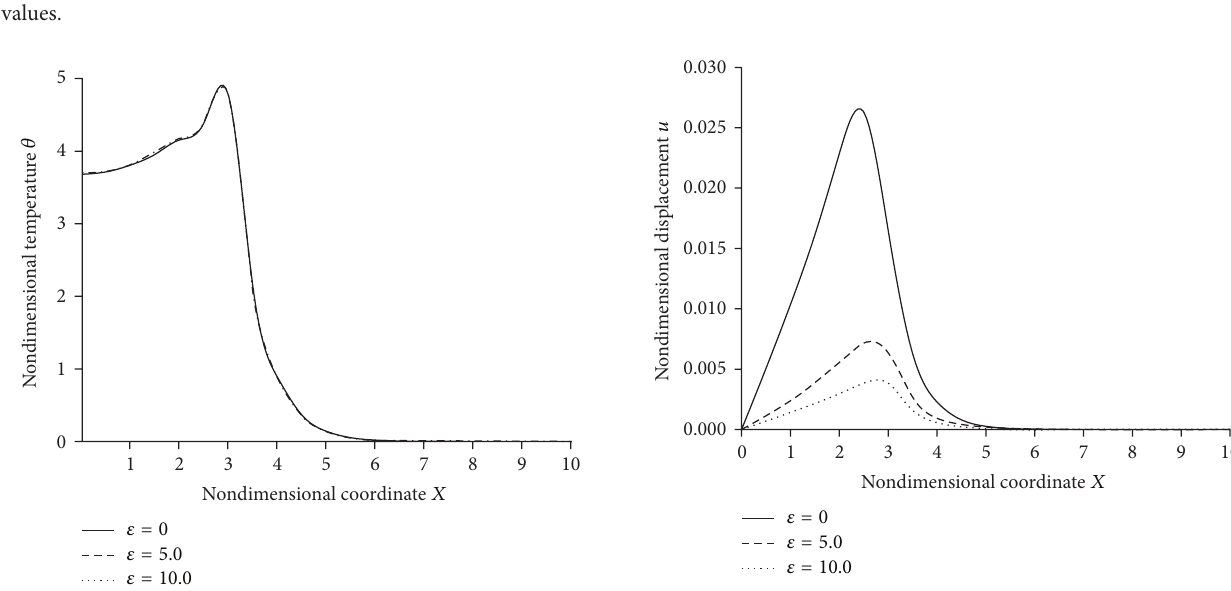
Figure 8: Nondimensional stress distribution for different 𝜀 values.